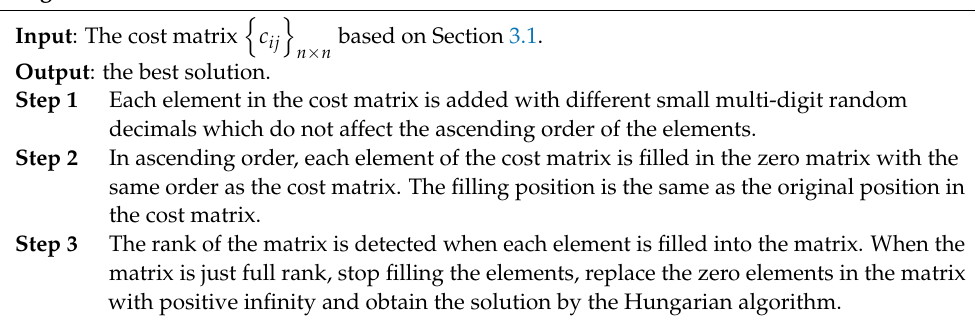
Algorithm 1 Minimize the max cost and reduce the total